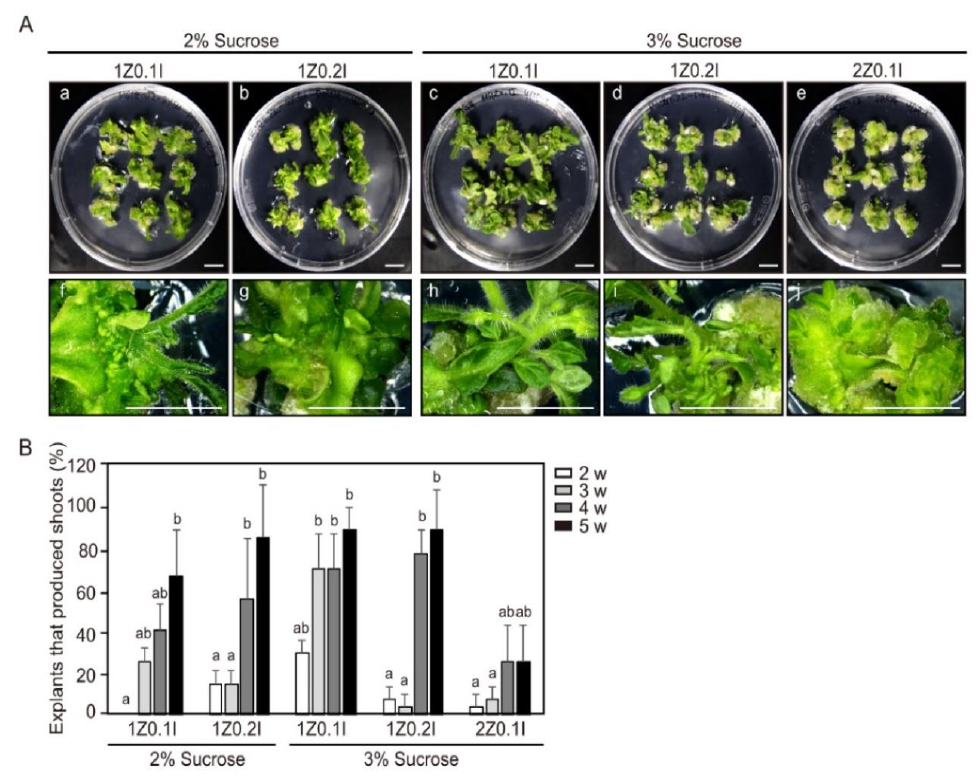
Figure 1. Effect of hormones and sucrose concentration in the shoot induction medium (SIM) for adventitious shoot formation. ( A ) Cotyledon explants of 4-days-after-germination seedlings were cultured in SIM. Plant explants 4 weeks ( a – e ) and 5 weeks ( f – j ) after incubation. ( a , f ) 1 mg L −1 Zeatin, 0.1 mg L −1 Indole-3-acetic acid (IAA), and 2% sucrose; ( b , g ) 1 mg L −1 Zeatin, 0.2 mg L −1 IAA, and 2% sucrose; ( c , h ) 1 mg L −1 Zeatin, 0.1 mg L −1 IAA, and 3% sucrose; ( d , i ) 1 mg L −1 Zeatin, 0.2 mg L −1 IAA, and 3% sucrose; ( e , j ) 2 mg L −1 Zeatin, 0.1 mg L −1 IAA, and 3% sucrose. Scale bars = 1 cm. ( B ) The